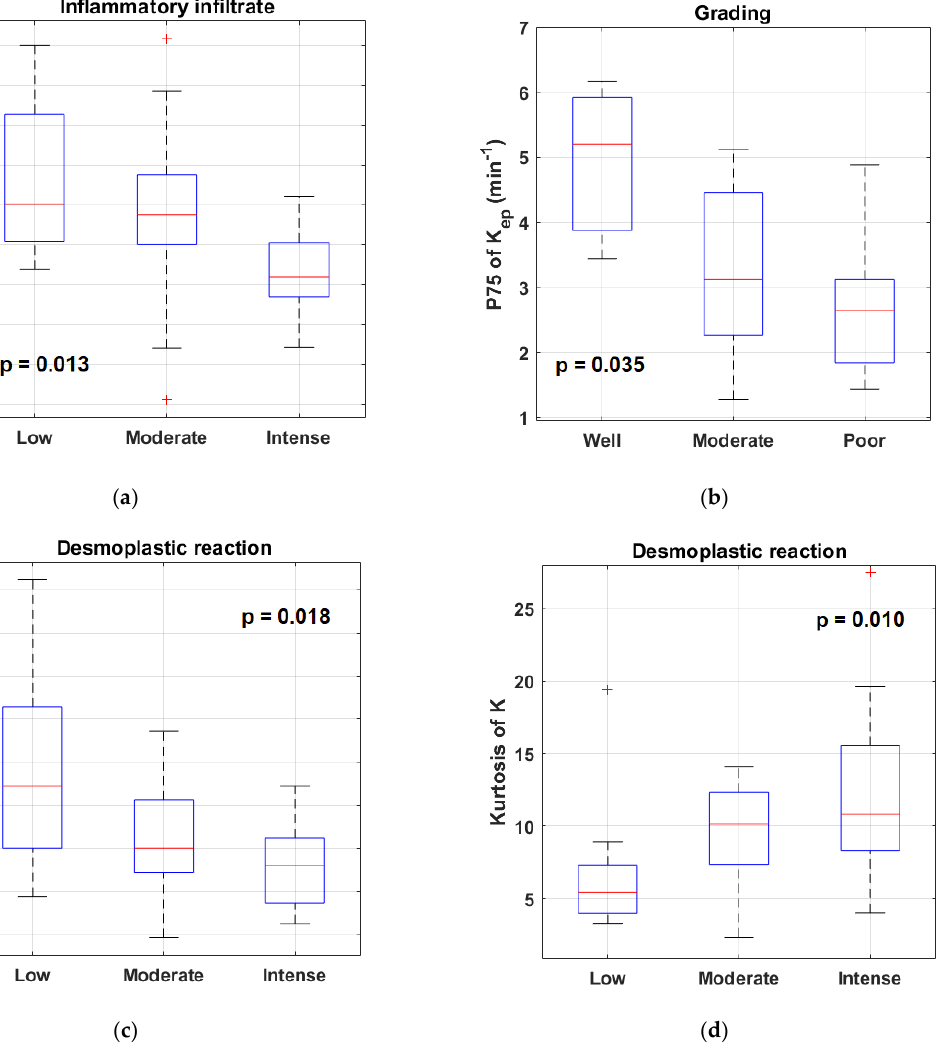
Figure 1. Comparison of mean D values between different groups according to the degree of inflammatory infiltrate ( a ); comparison of P75 values of K ep between different groups according to the degree of tumor grading ( b ); comparison of median K ep values and kurtosis values of K between different groups according to the level of desmoplastic reaction (( c ) and ( d ), respectively). Outliers are plotted with square markers.